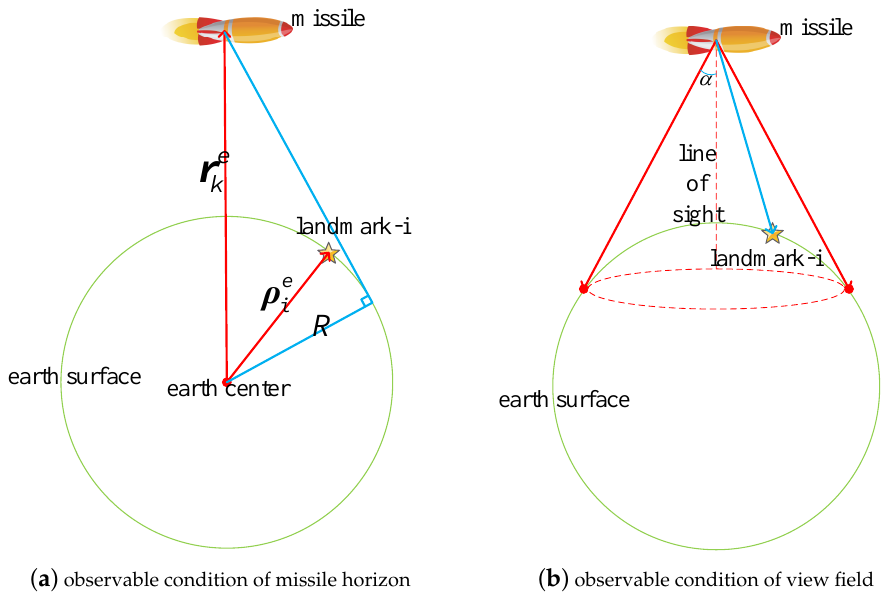
Figure 3. Physical observability analysis